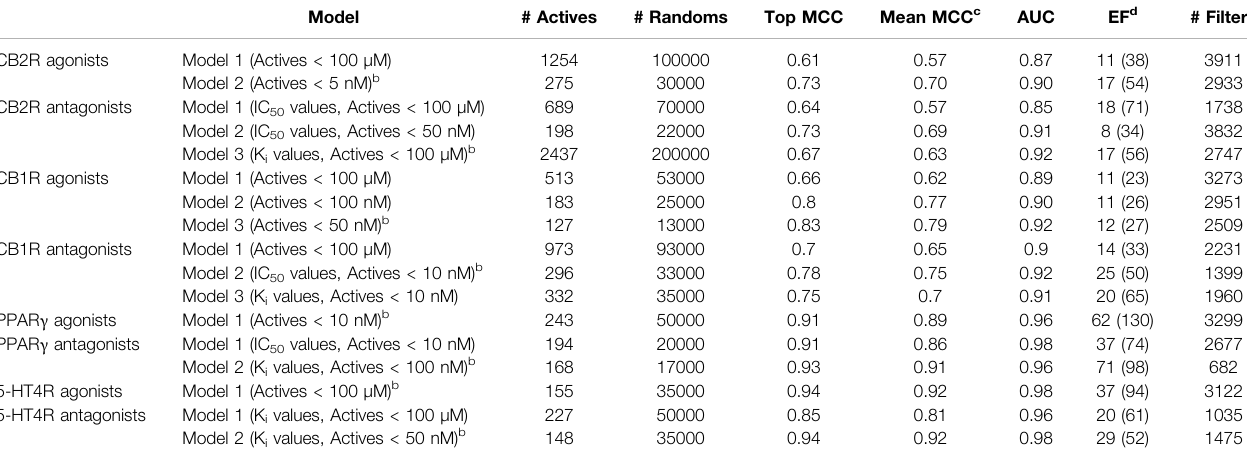
TABLE 1 | Models of agonists and antagonists for the four receptors a .